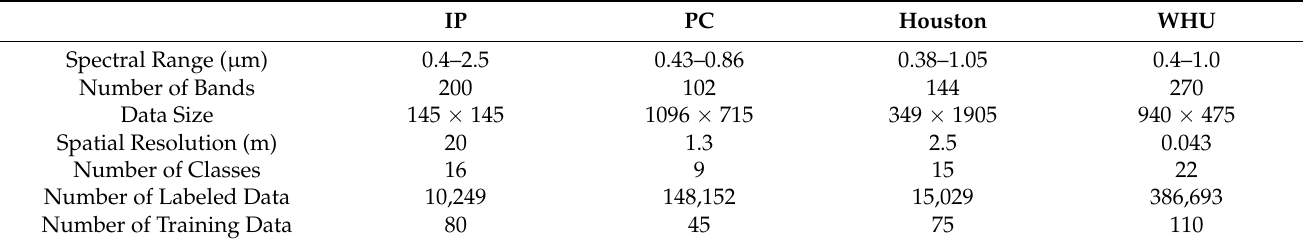
Table 2. Detailed information of the experimental